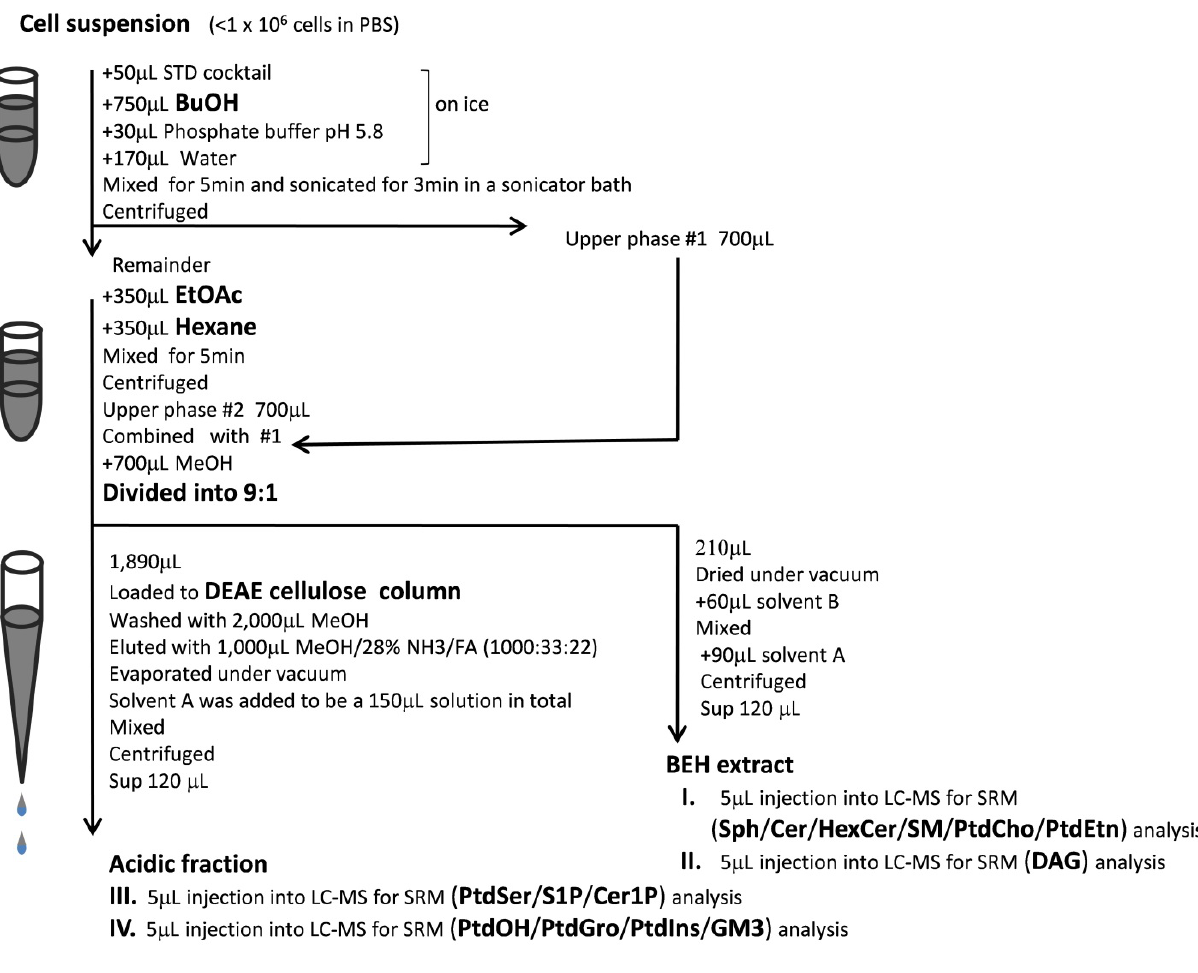
sphingosine; Cer, ceramide; HexCer, monohexosylceramide; SM, sphingomyelin; PtdSer, phosphatidic acid; PtdGro, phosphatidylglycerol; PtdIns, phosphatidylinositol; GM3, monosialoganglioside; STD, standard solution; FA, formic